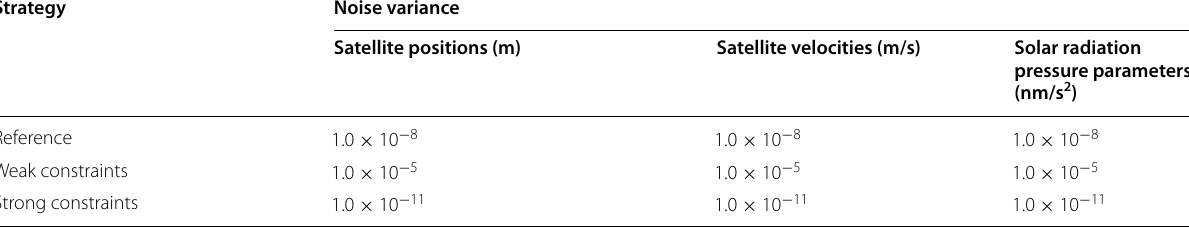
Table 2 Noise variance settings for the orbit parameters